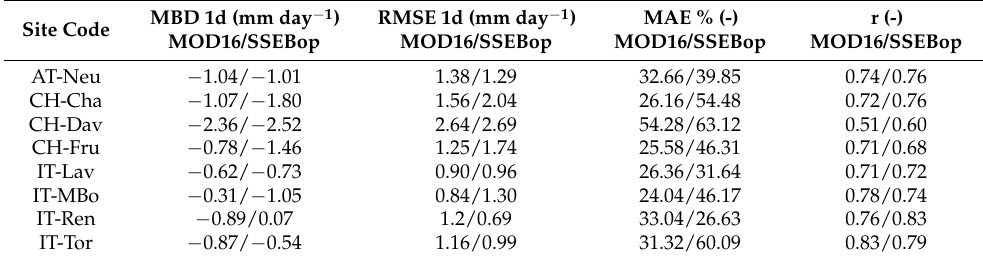
Table 2. Metrics of the comparison between the MOD16A2 and SSEBop products, and latent heat flux measured at selected Fluxnet stations in the Alps. The validation results are summarized in terms of average daily mean bias deviation (MBD 1d), average daily root mean square error (RMSE 1d), mean absolute error as percentage of the observed value cumulated over 8 (for MOD16) or 10 (for SSEBop) days (MAE %), and correlation coefficient of the linear regression (r).